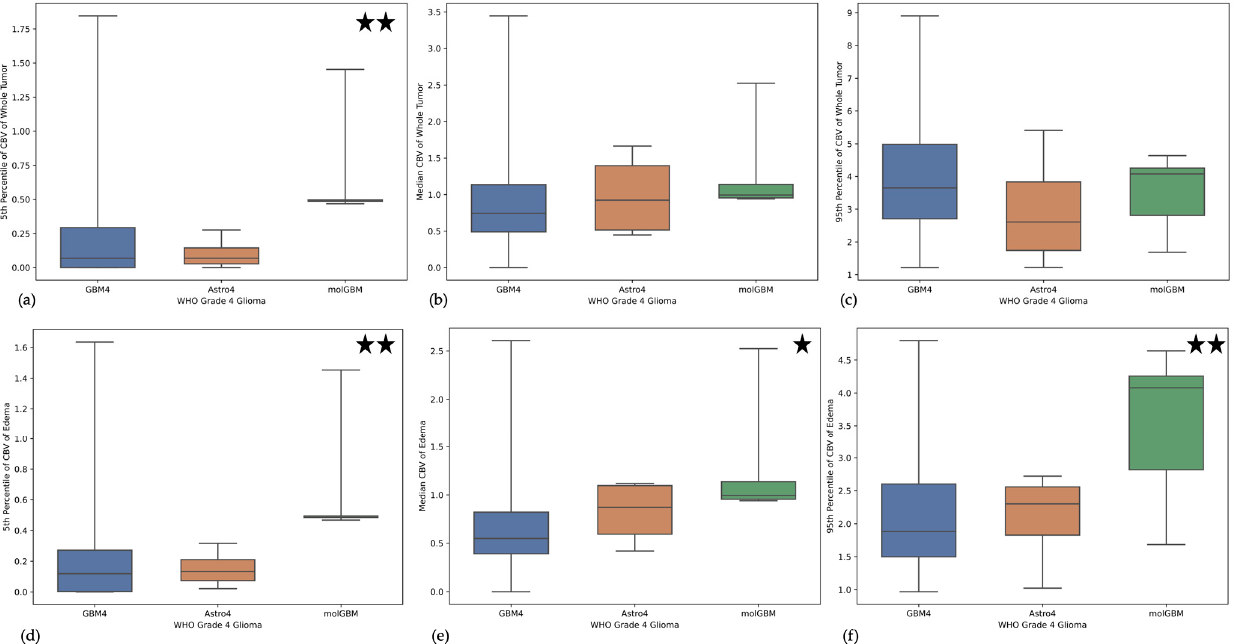
Figure 4. Boxplots illustrating the distribution of 5th percentile, median, and 95th percentile cerebral blood volume (CBV) values in the whole tumor volume ( a – c ) and the non-enhancing/edema part ( d – f ) for “classical” glioblastoma (GBM4), astrocytoma of WHO CNS grade 4 (Astro 4), and molecular glioblastoma (molGBM). Stars indicate significance of p < 0.05 (one star) and p < 0.01 (two stars), respectively.